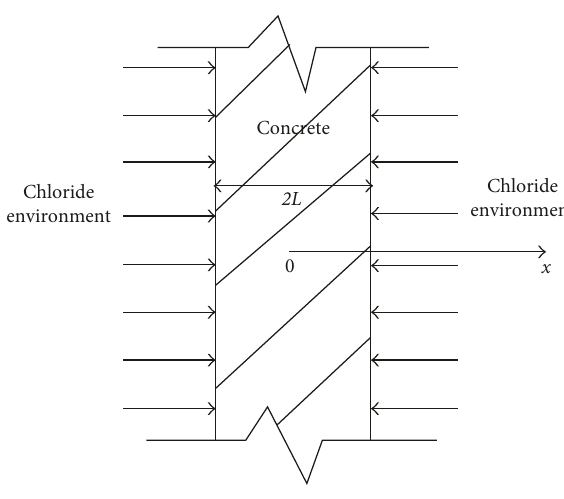
Figure 2: Ideal infinite concrete